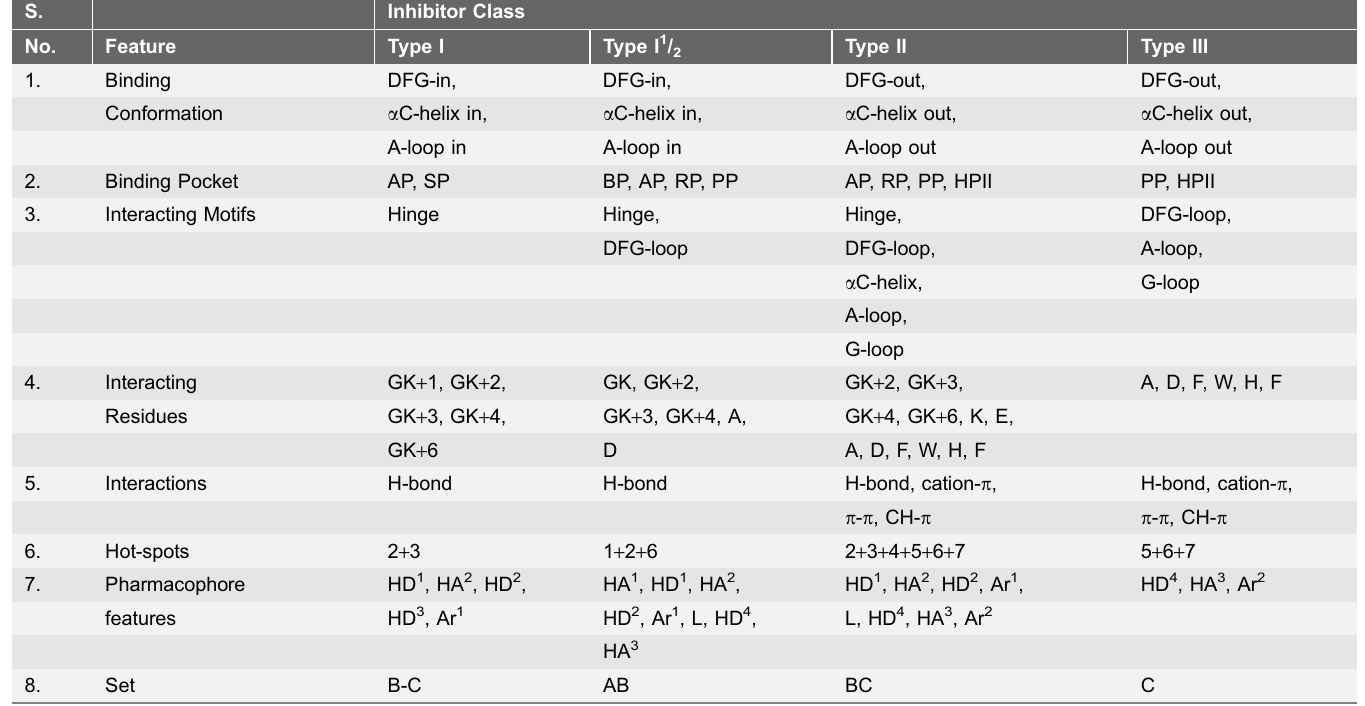
Table 4. Insights obtained for the design of AK